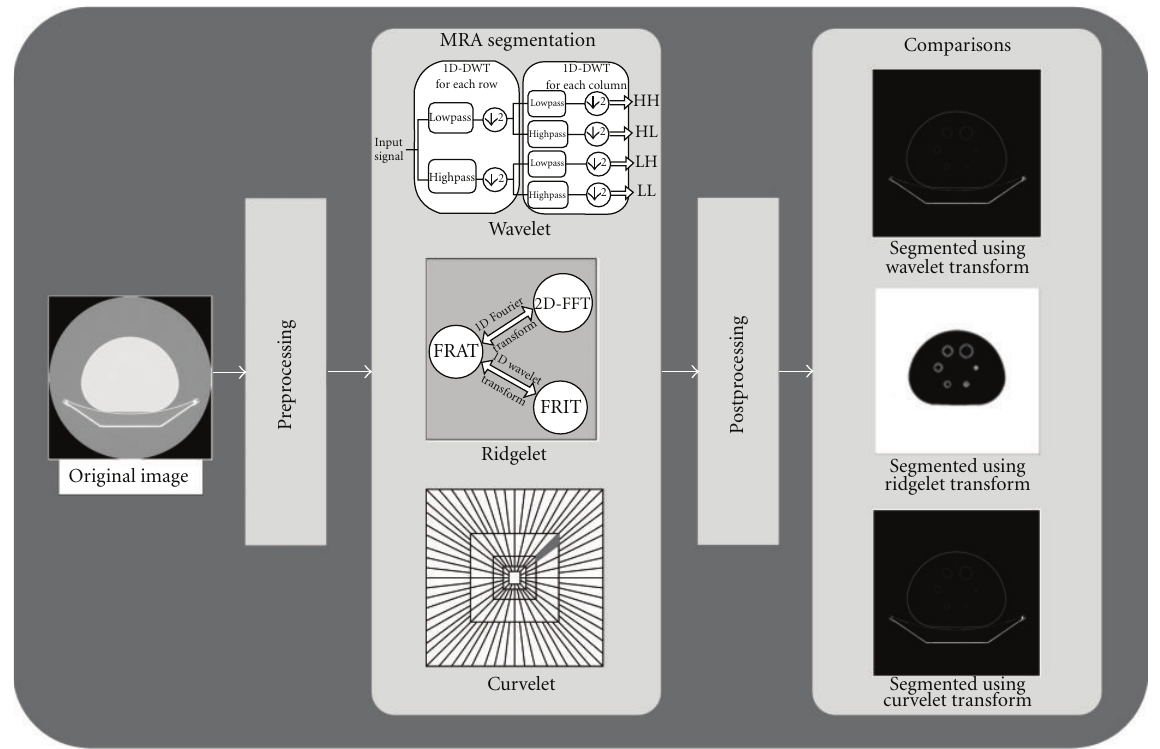
Figure 1: Proposed segmentation system for medical